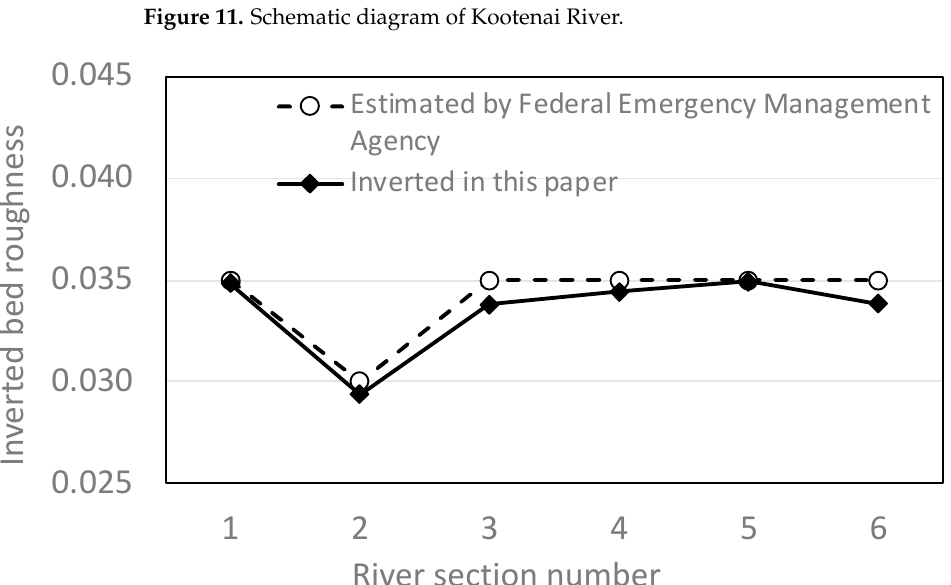
Figure 12. Inversed bed roughness at different river sections, and their comparison with the estimated values by Berenbrrock and Bennett.